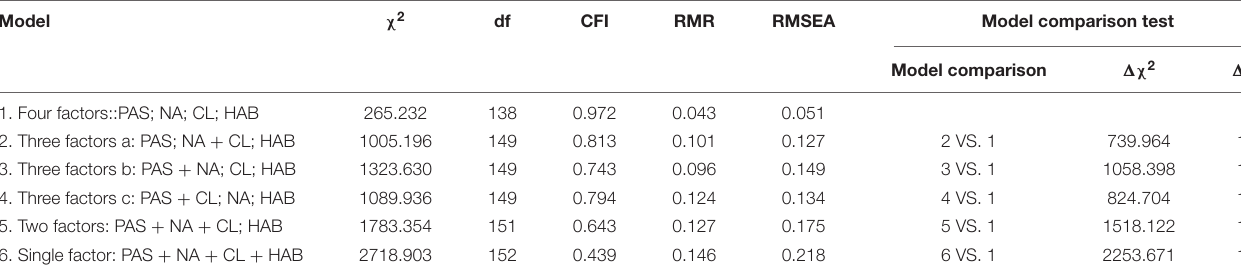
TABLE 3 | Model fit results for confirmatory factor analyses ( n = 355). Model